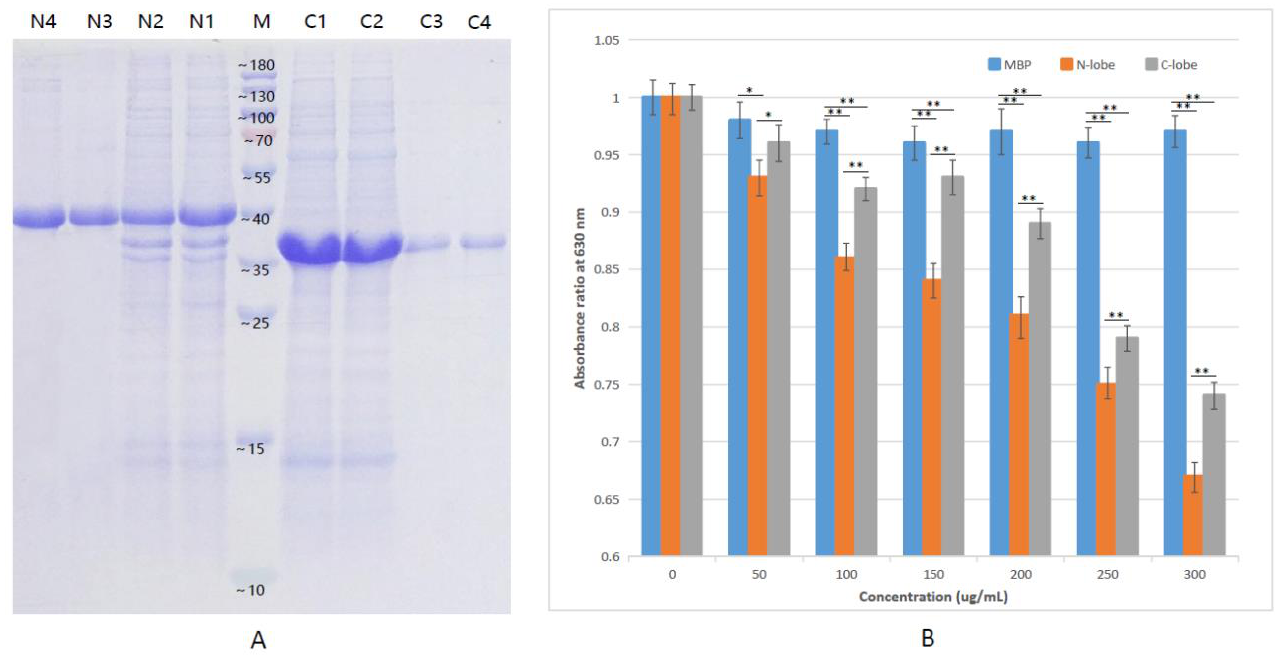
Figure 6. Protein expression and iron-binding activity. ( A ) SDS-PAGE analysis of Amur stickleback TF N-lobe and C-lobe. Lines: M — marker; N1 and N2 — soluble fraction after sonication of N-lobe expressed cells; N3 and N4 — purified N-lobe fragments after elution; C1 and C2 — soluble fraction after sonication of C-lobe expressed cells; C3 and C4 — purified C-lobe fragments after elution; ( B ) Iron-binding activity of the TF N-lobe and C-lobe in Amur stickleback. The x-axis represents the protein concentration, and the y-axis represents the light absorption value at 630 nm. Values were described as mean ± SE ( n = 3). Asterisks (* p < 0.05; ** p < 0.01) indicated the statistically significant differences between treatments.